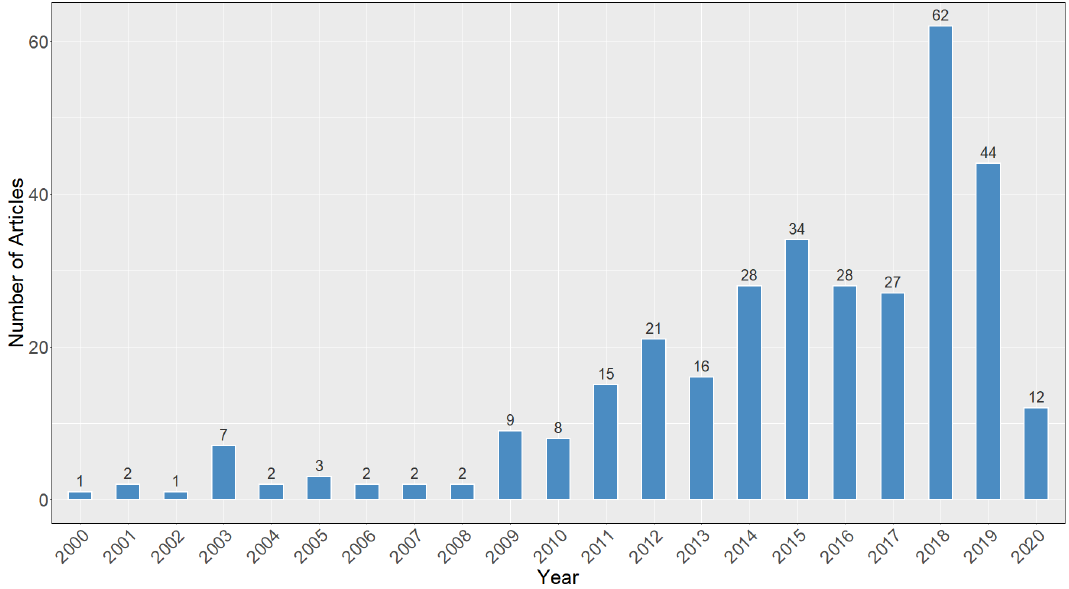
Figure 3. Number of permafrost related satellite Earth observation studies per year based on the reviewed